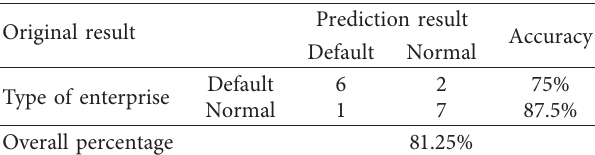
Table 8: Accuracy of logistics model.